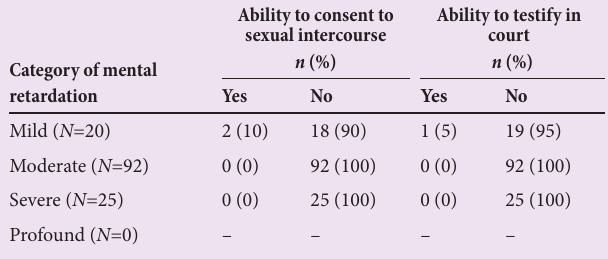
Table 4. Ability to consent to intercourse and testify in